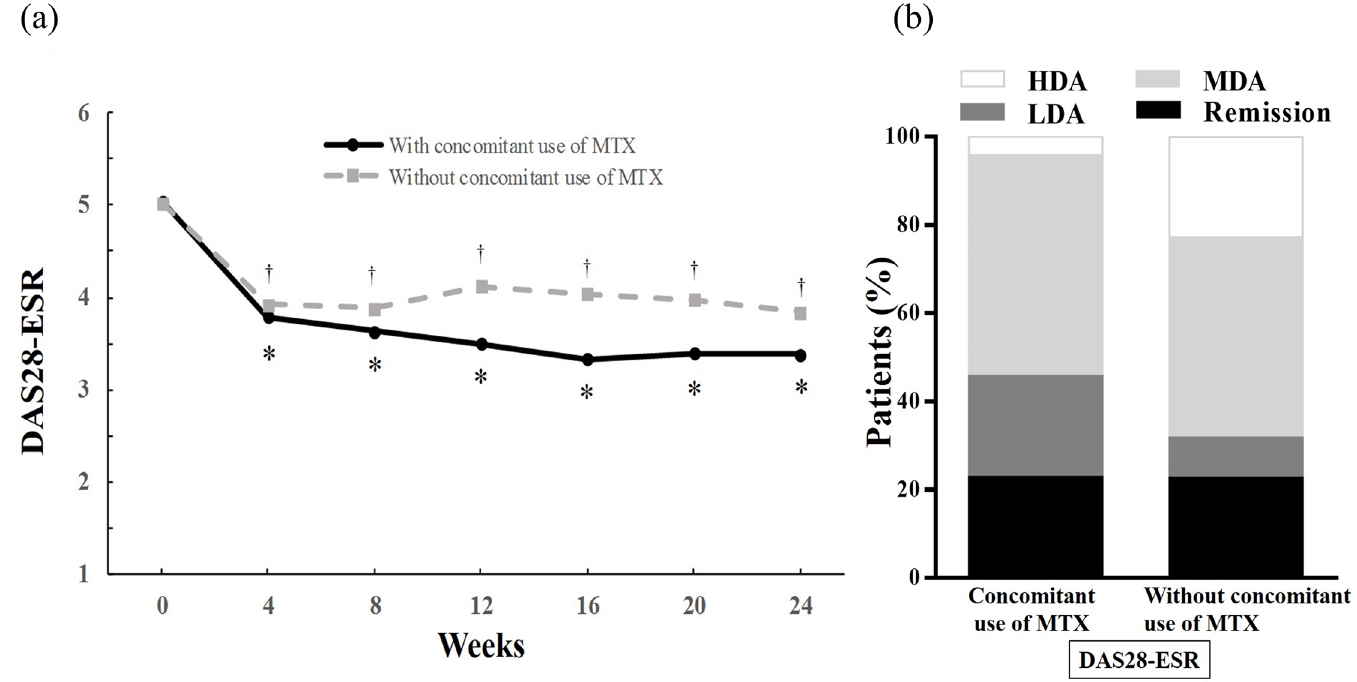
Fig 3. (a) Time course of the disease activity score over 24 weeks following the initiation of tofacitinib treatment with or without concomitant use of MTX. Data were analyzedby the LOCF method. Points represent means. * p < 0.0001 versus baselineby the Wilcoxon signedrank test. † p < 0.05 versus baselineby the Wilcoxon signed rank test. (b) The proportion of disease activity at 24 weeks after initiation of tofacitinib treatment with or without concomitant use of MTX. Disease activity was categorizedas follows. DAS 28-ESR < 2.6(remission), 2.6- (cid:20) 3.2(LDA), 3.2- (cid:20) 5.1(MDA), 5.1 < (HDA). MTX methotrexate, LOCF last observation carried forward, ESR erythrocyte sedimentation rate, DAS diseaseactivity score, LDA low disease activity, MDA moderate diseaseactivity, HDA high